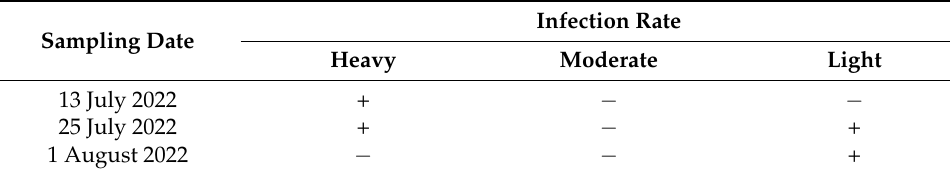
Table 2. Classification of Marteilia refringens